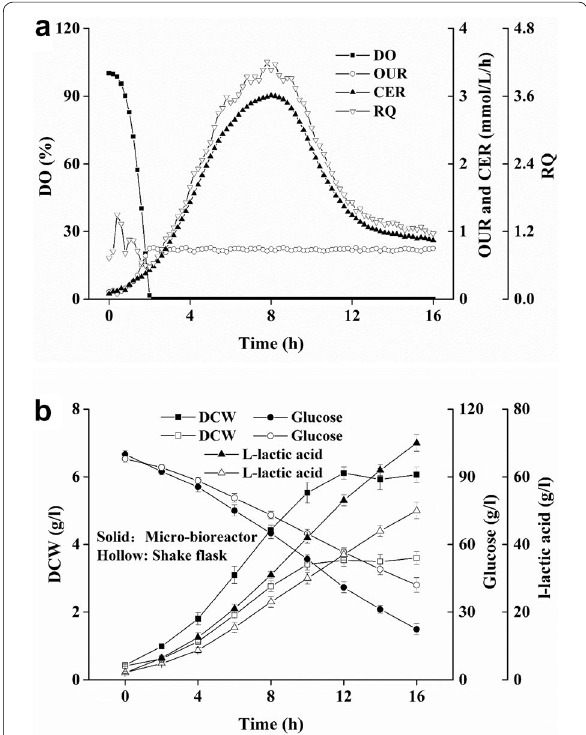
Fig. 6 Time profiles of DO, OUR, CER, and RQ in L. paracasei culture with a micro-bioreactor ( a ); comparison of the cell growth, glucose consumption, and l -lactic acid production in L. paracasei cultures with micro-bioreactor and shake flask ( b )